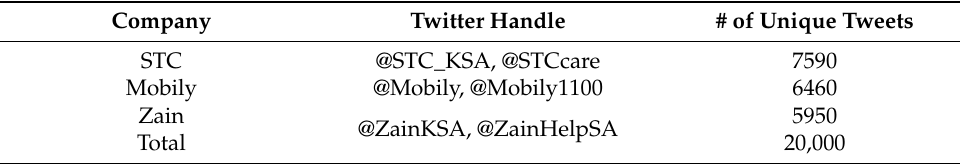
Table 4. Companies and the Total Number of Unique Tweets for AraCust.